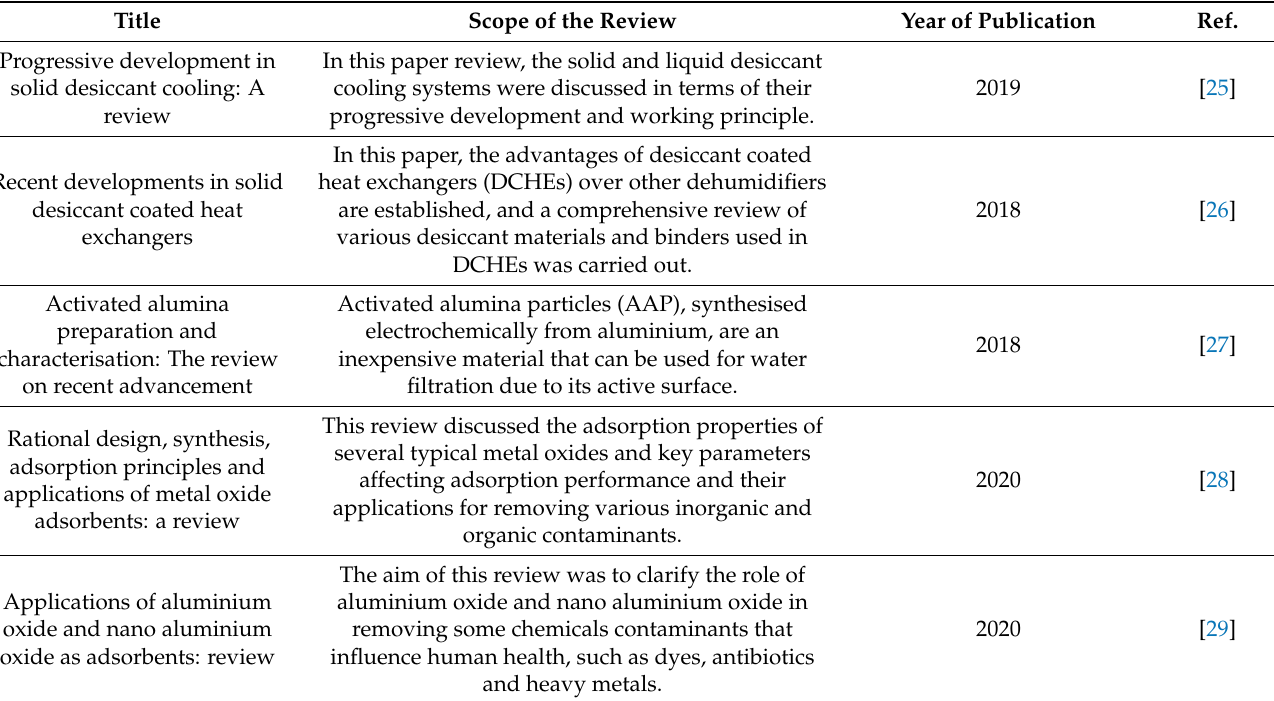
Table 1. Titles, scope and references of the main review, focusing on the topics of the adsorbents based on aluminium